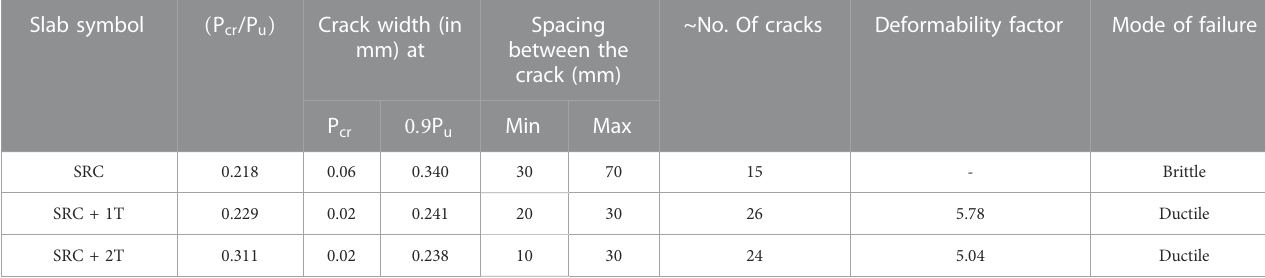
Spacing mm) at between the